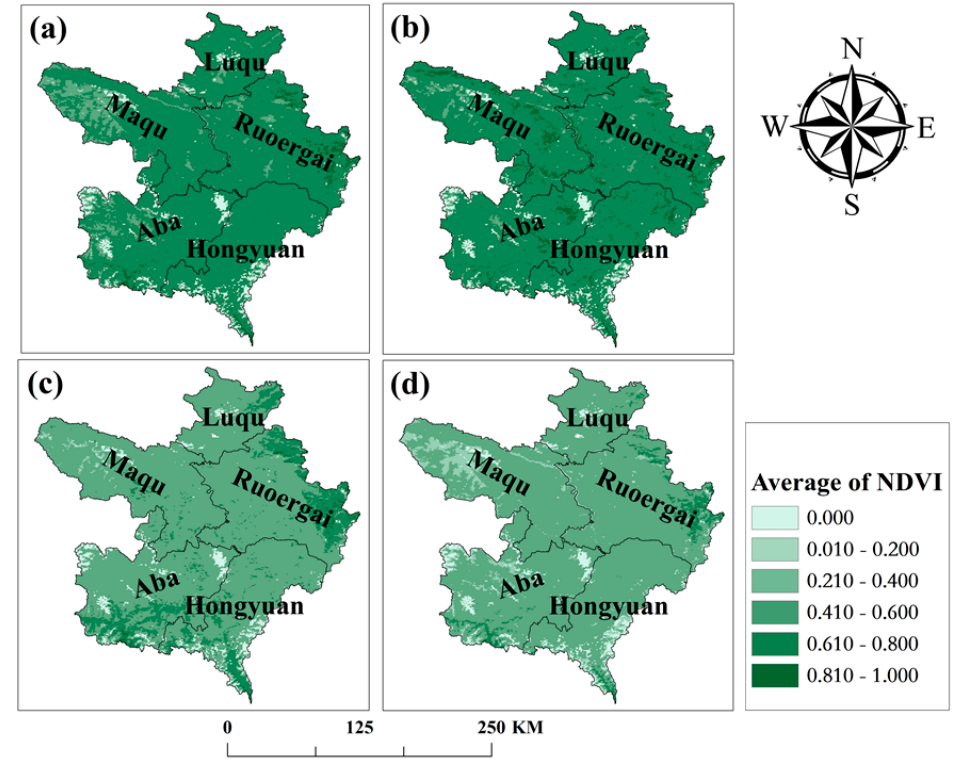
Figure 8. Spatial distribution of the mean NDVI values in different seasons in the RWA from 1982 to 2018: ( a ) spring; ( b ) summer; ( c ) autumn; and ( d ) winter. In general, the NDVI values in winter, spring, and summer ranged from 0.210 to 0.400, 0.410 to 0.600, and 0.610 to 0.80, respectively (Figure 8). The RWA showed a more